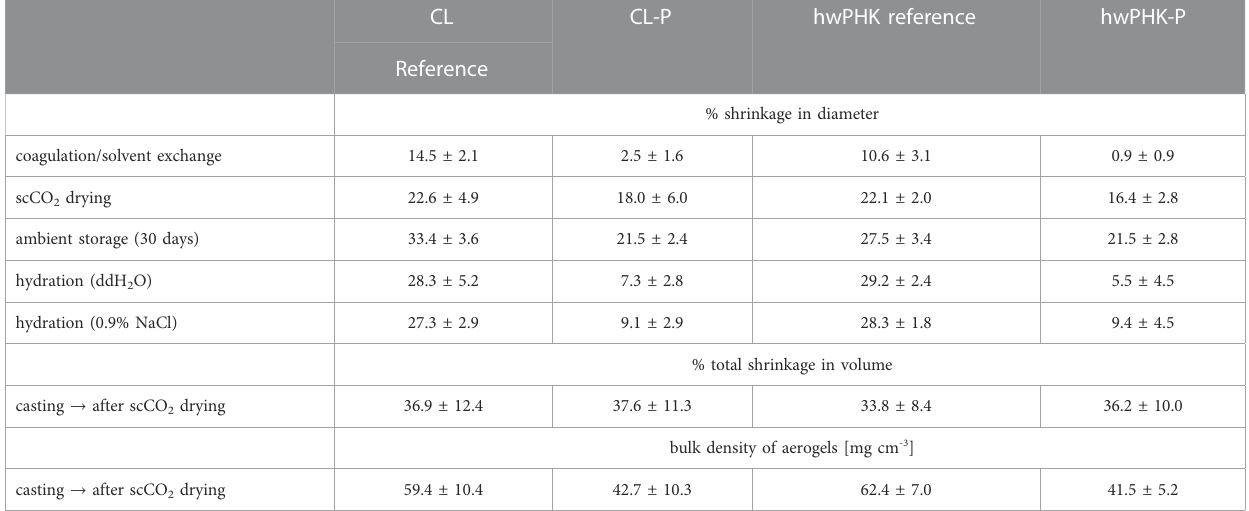
TABLE2Contractionofthedisk-typecellulosicscaffolds(Ø45mm)weremeasuredbyacaliperthroughoutthedifferentstepsofcellulosecoagulationandsolvent exchange, scCO 2 drying, storage in air, hydration with bidistilled H 2 O and equilibration in 0.9 % NaCl. Measurements were repeated until no further volume contraction occurred. Total volumetric shrinkage in the sum of all process steps, including scCO 2 drying and bulk density of the aerogels obtained. (Mean ± standard deviation, n =